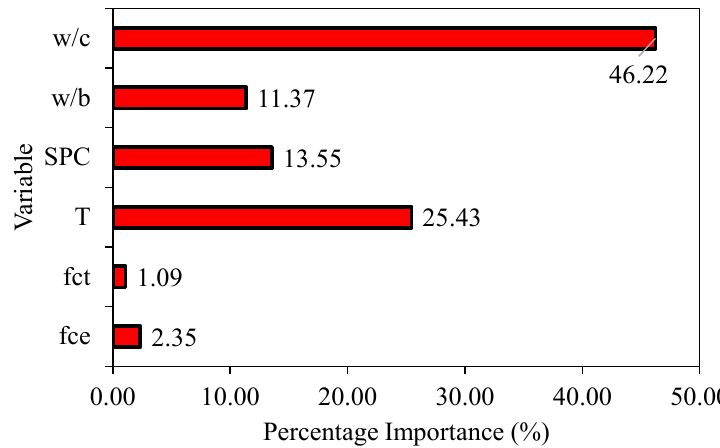
Figure 10. Sensitivity analysis of the developed model.